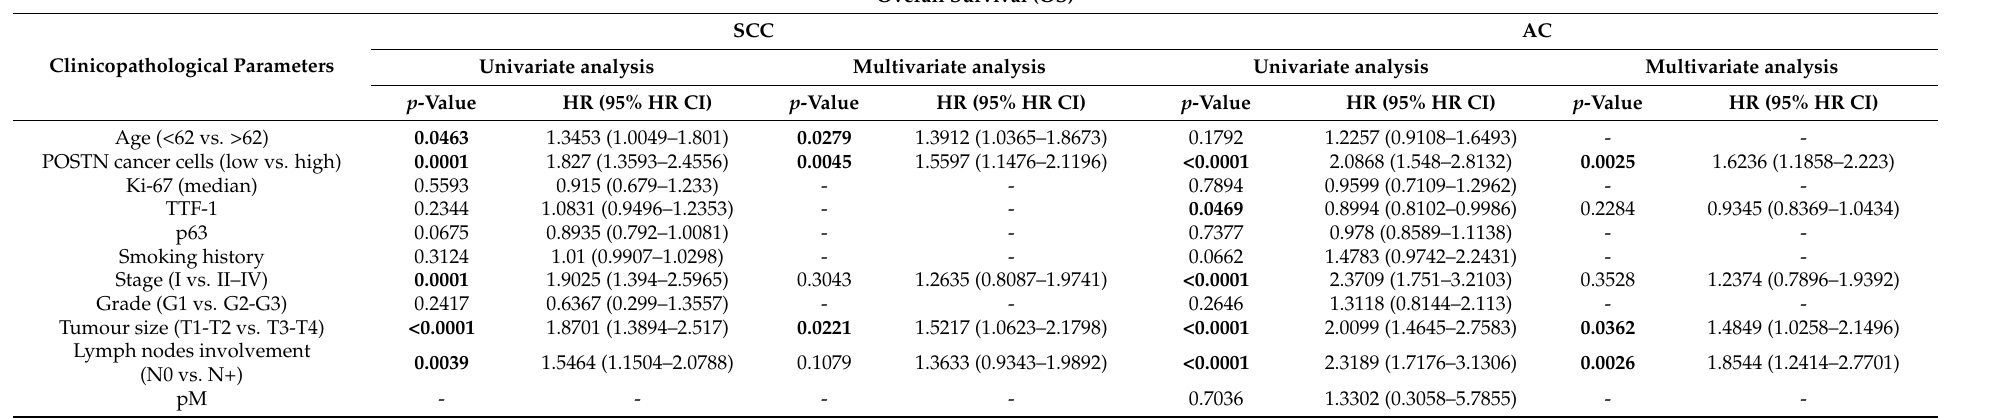
Overall Survival